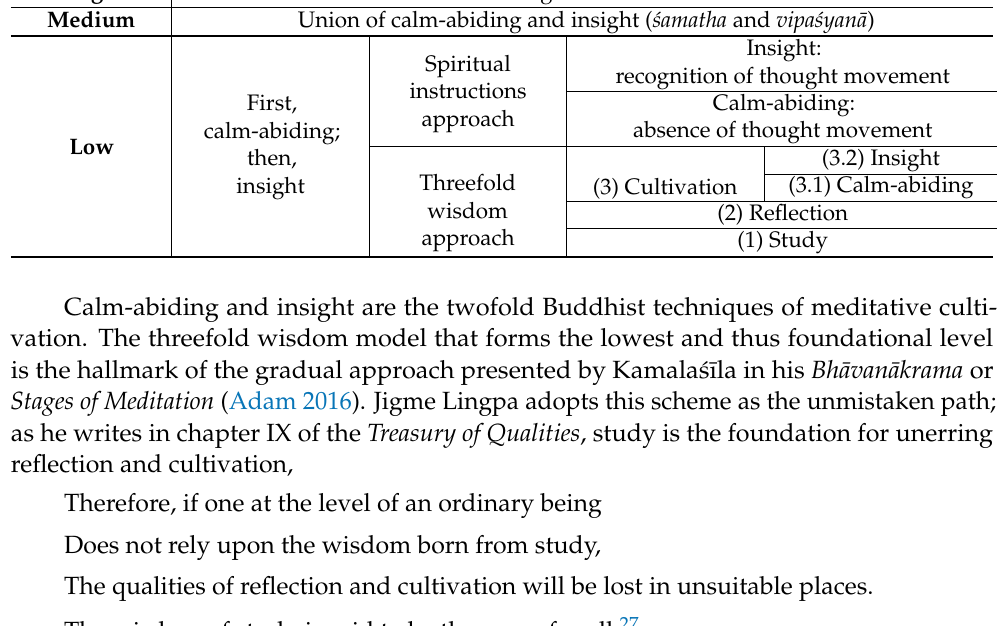
Table 1. Levels of Dzogchen practice according to the Treasury of Qualities , XII. High Natural settling: no need for antidotes